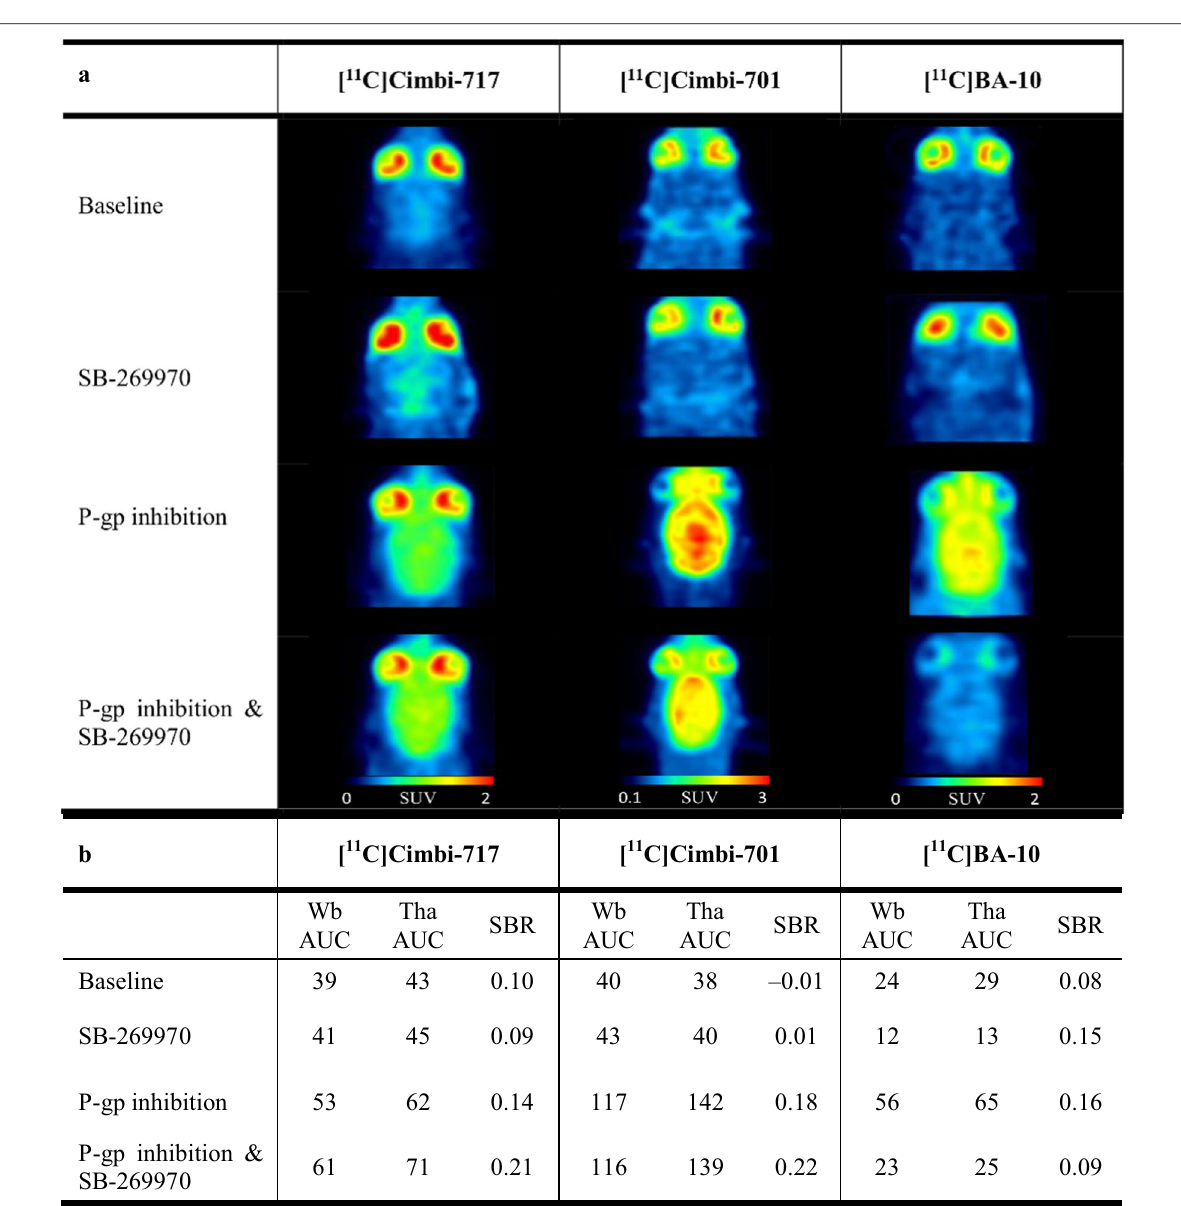
Fig. 3 PET images ( a ), AUC and SBR values ( b ) for the 5-HT 7 receptor tracers [ 11 C]Cimbi-717, [ 11 C]Cimbi-701, and [ 11 C]BA-10. Representative horizontal rat PET images, 60-min AUC values (min g/mL) and SBR values are shown for baseline, target block with SB-269970, P-gp inhibition with × elacridar and combined P-gp inhibition—target block conditions (see Table 1 for details on drug dosing and PET image summation). Numbers of rats scanned per experimental condition are shown in Additional file 1: Table S2. Wb whole brain, Tha thalamus, Cb cerebellum, AUC area under the curve, SBR specific binding ratios, P-gp